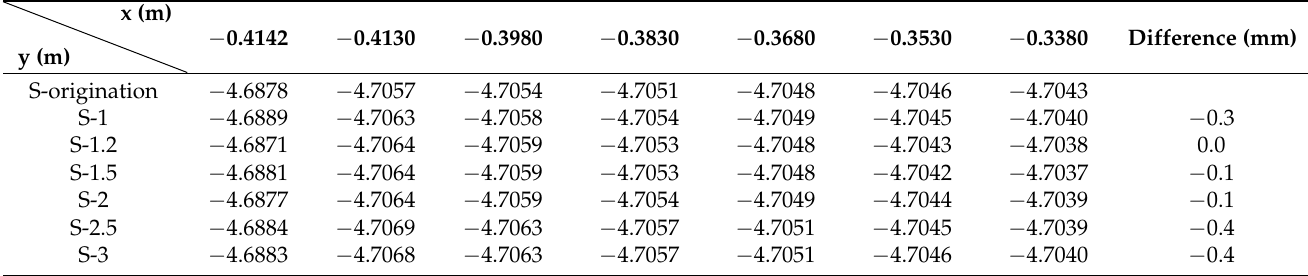
Table 6. Comparison of data points of statue.